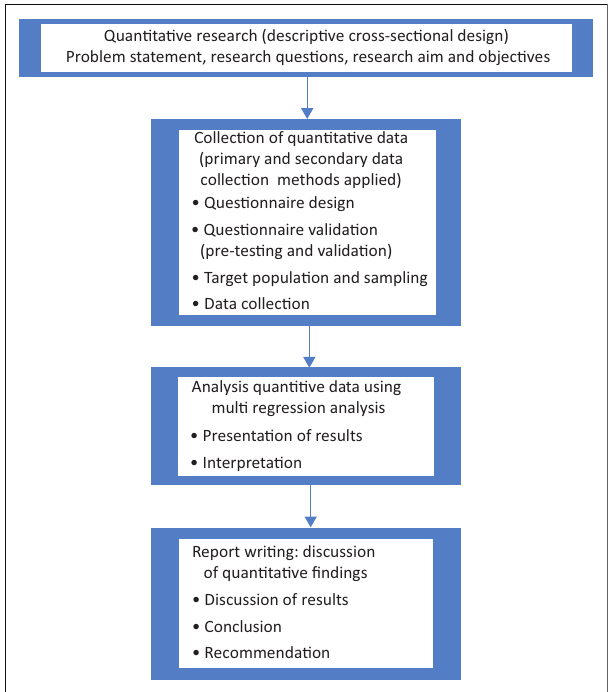
FIGURE 2: Flowchart for the survey research